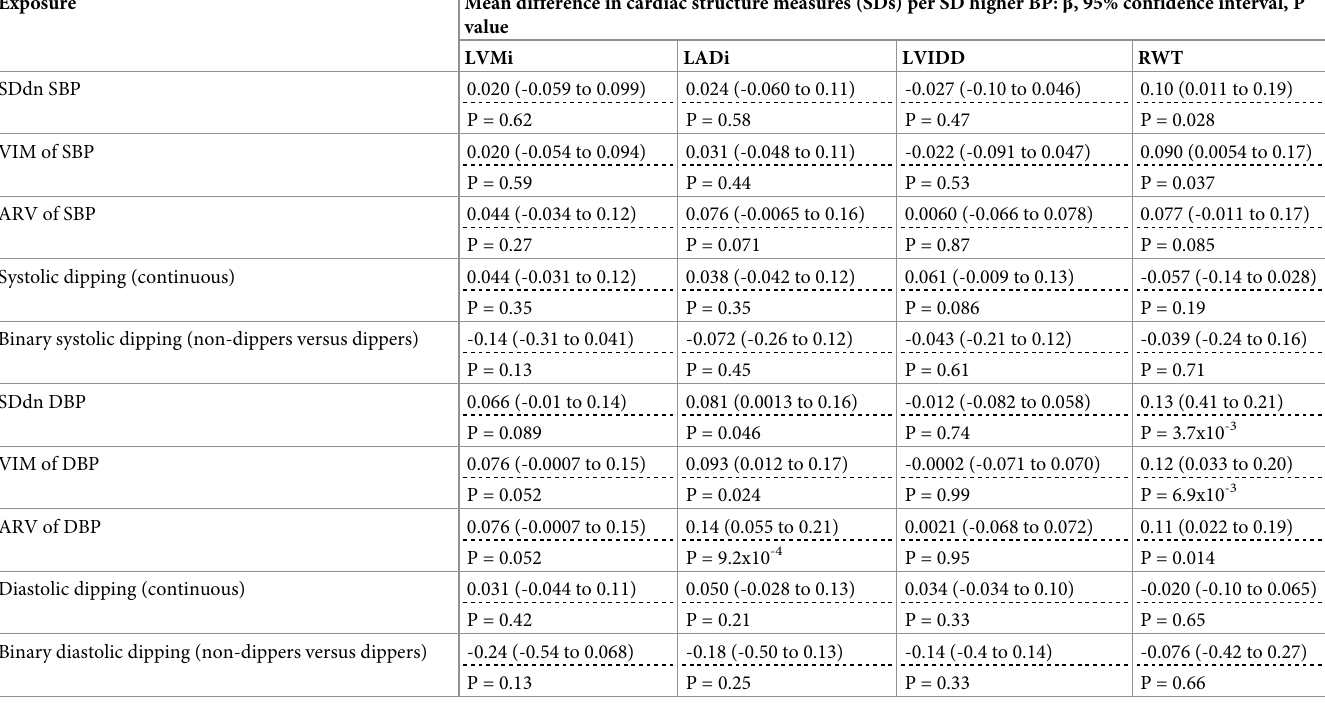
Table 3. Associations of BP variability and dipping with cardiac structure after adjustment for 24-hour mean BP, N = 587. Exposure